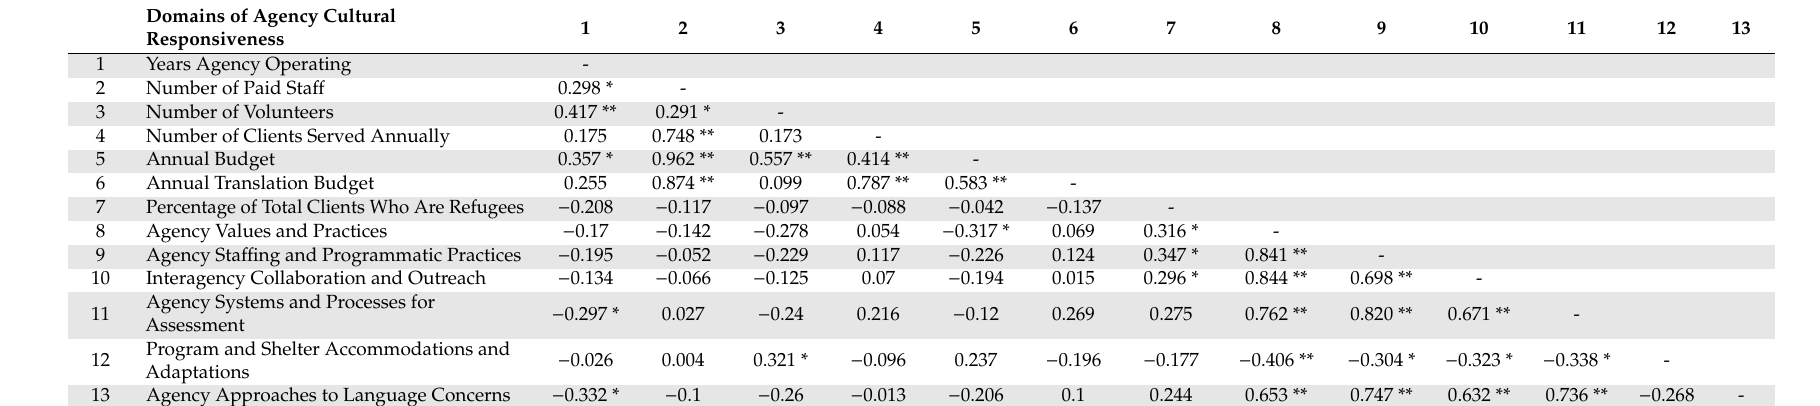
Table 3. Pearson Correlations among Agency Characteristics and Domains of Agency Cultural